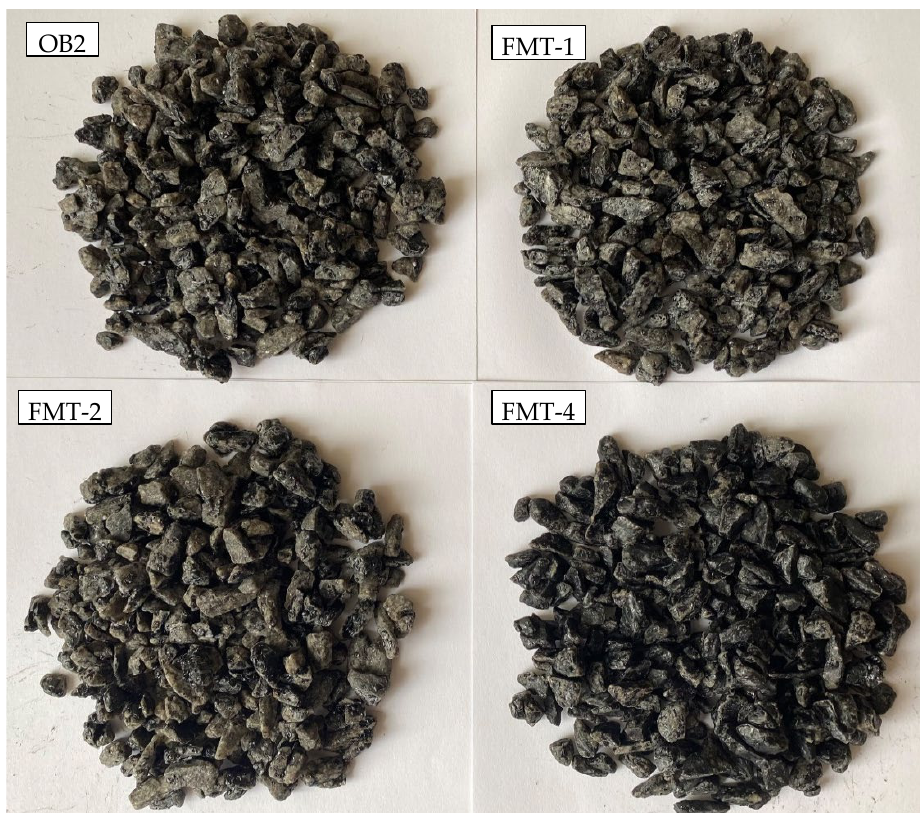
Figure 14. Results of the rolling bottle tests with S1.